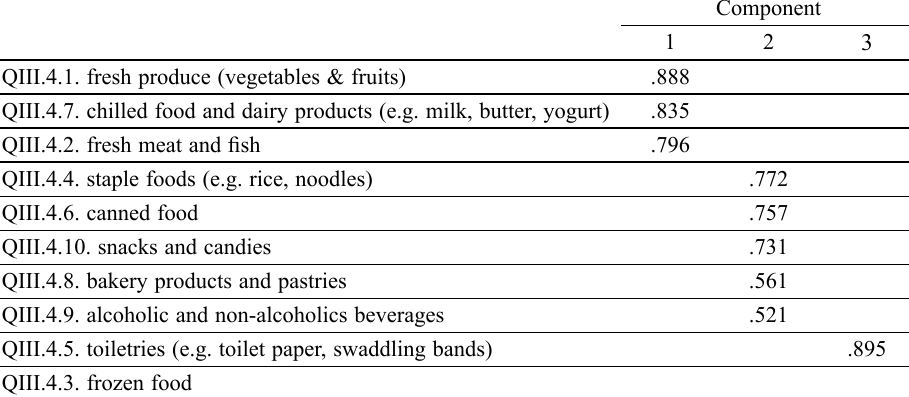
Table 2. Principal component for the German consumer’s favour/scepticism towards diverse foodstuff categories in the online